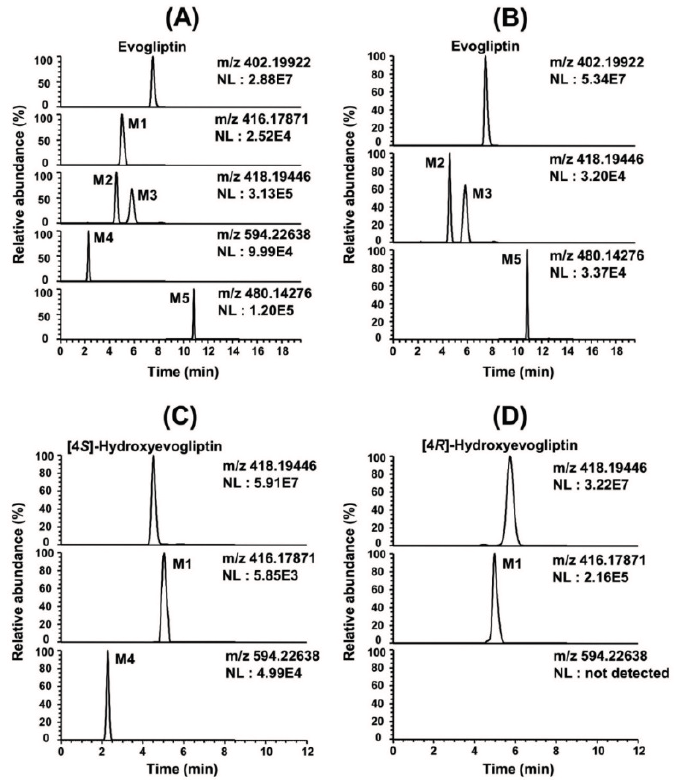
Figure 1. ( A ) Extracted ion chromatograms (EIC) of evogliptin and possible metabolites after incubation of evogliptin with human hepatocytes; ( B ) EIC of evogliptin and possible metabolites